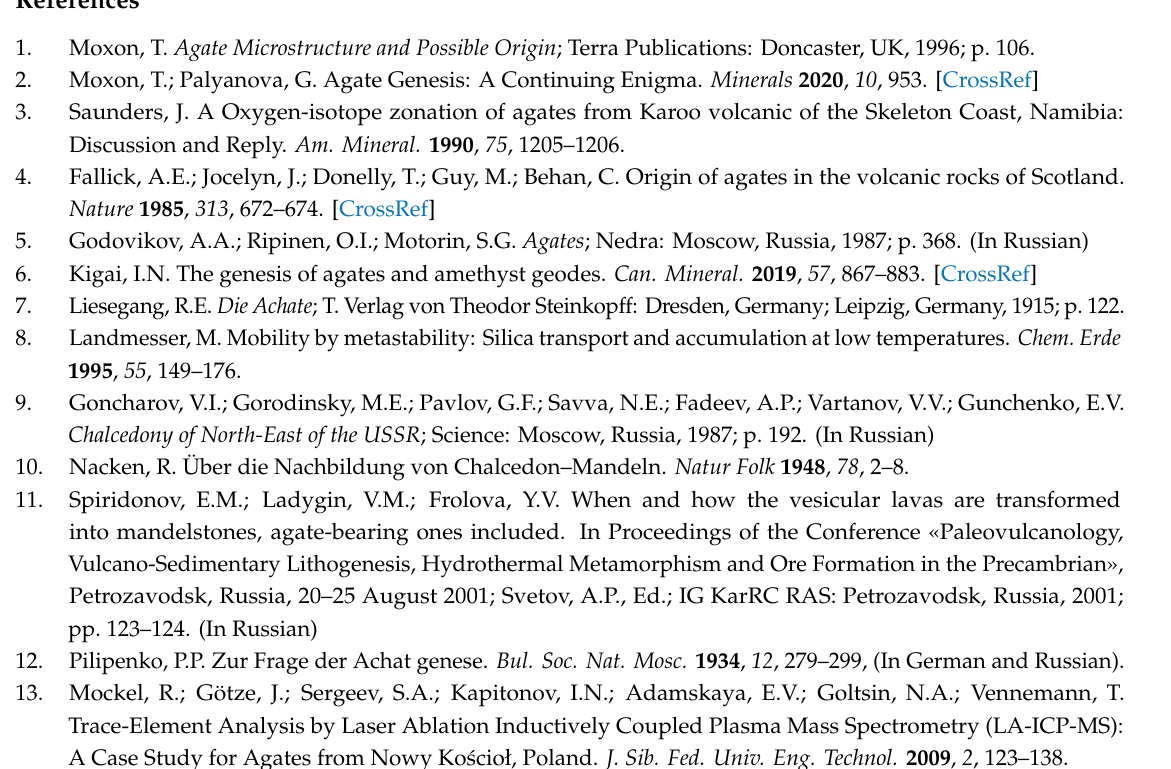
Onega Basin, Russia, by LA-ICP-MS, %,